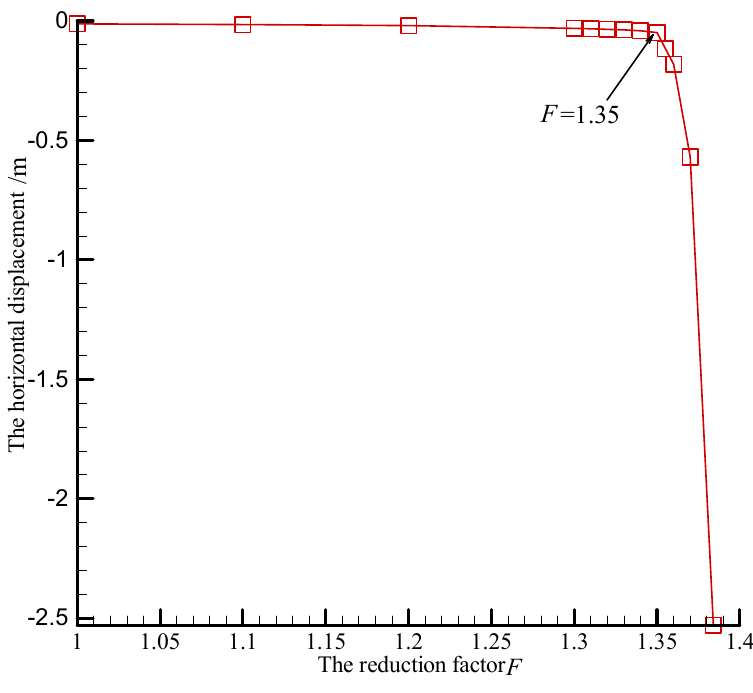
Figure 8. The horizontal displacement versus reduction factor.